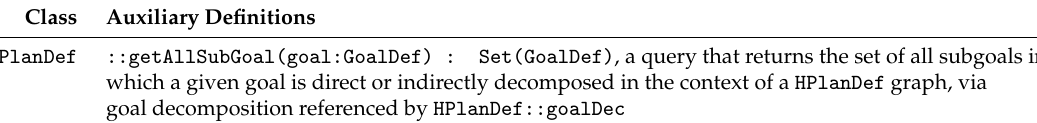
Table 3. Functional specification pattern: Contextual